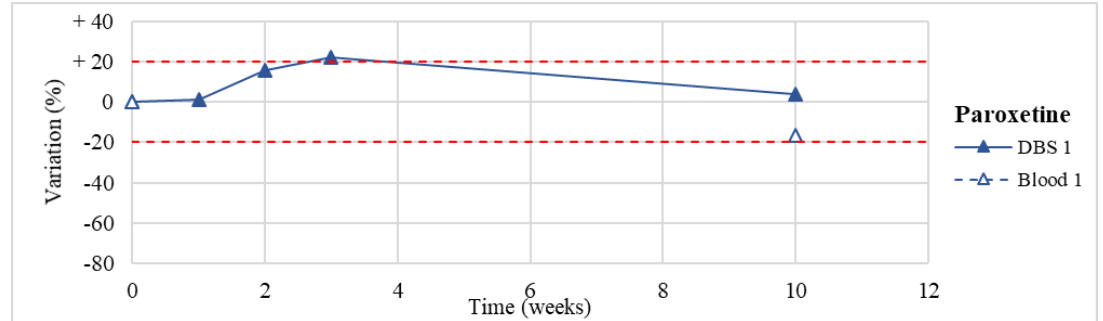
Figure 11. Stability of fluoxetine ( n = 1) in DBSs stored at room temperature and in blood stored at −20